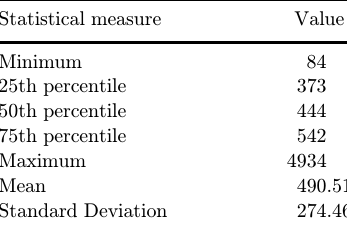
Table 1. Statistical measures of target variable (population of camp